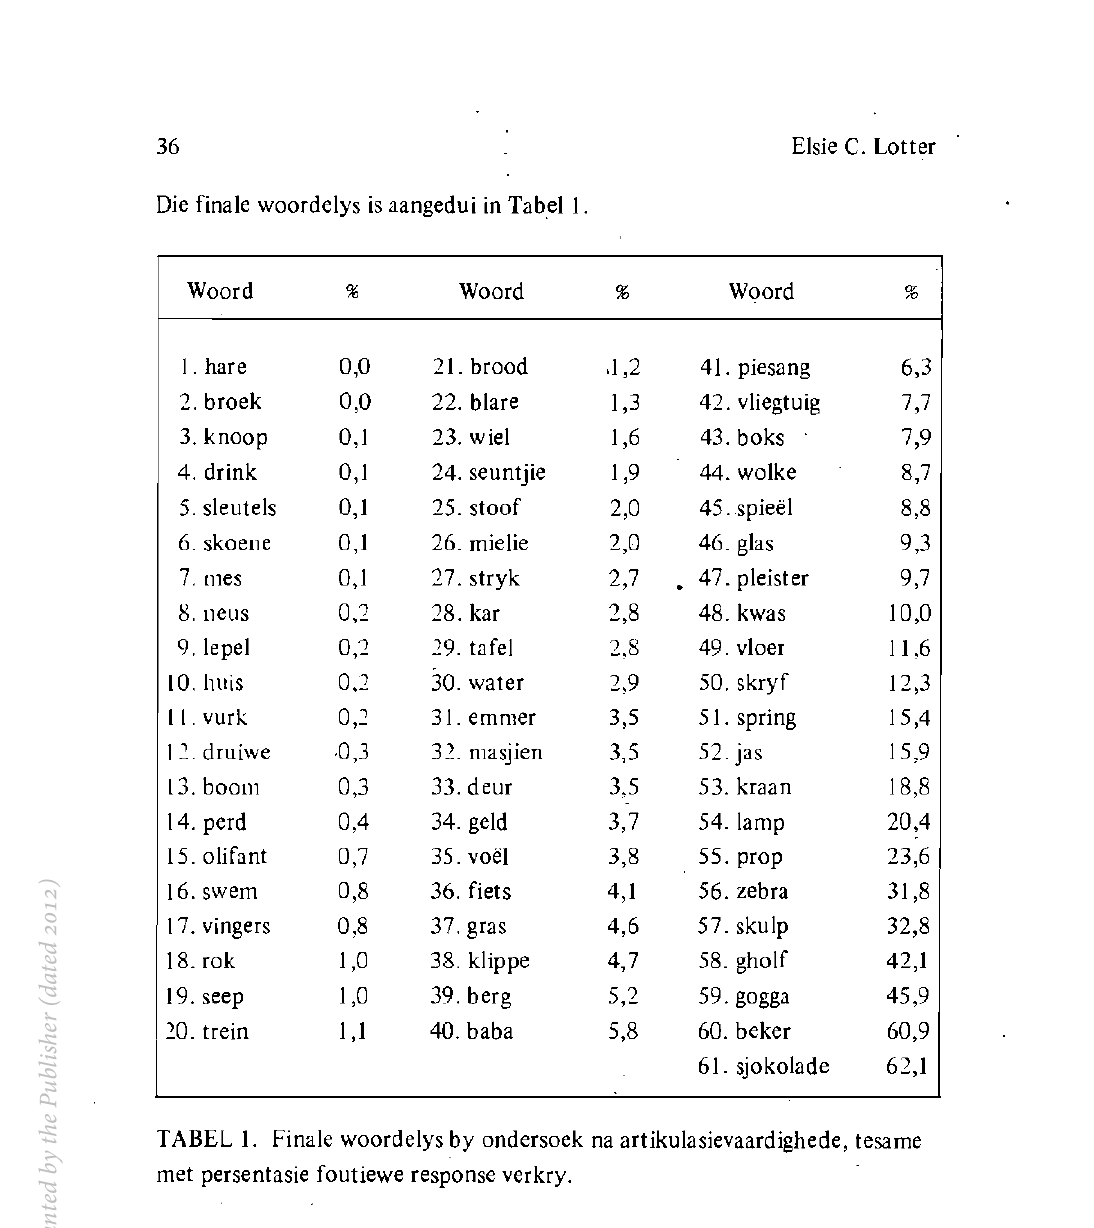
TABEL 1. Finale woordelys by ondersoek na artikulasievaardighede, tesame met persentasie foutiewe response